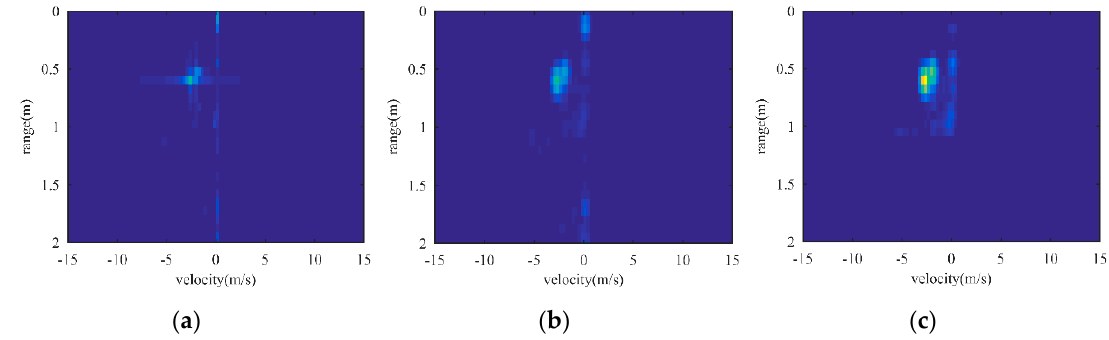
Figure 5. RDMs of different operations: ( a ) traditional RDM after Range Doppler FFT; ( b ) RDM after Windowing; and, ( c ) improved RDM after windowing and IF band pass filter.